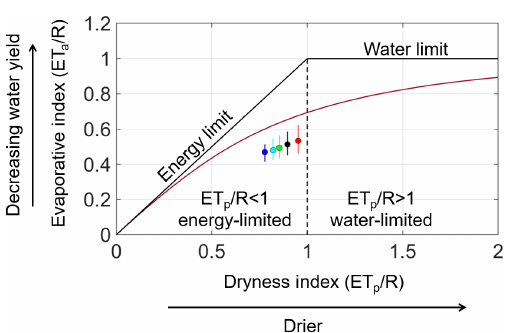
plot we depict the data points (colored dots) for the five